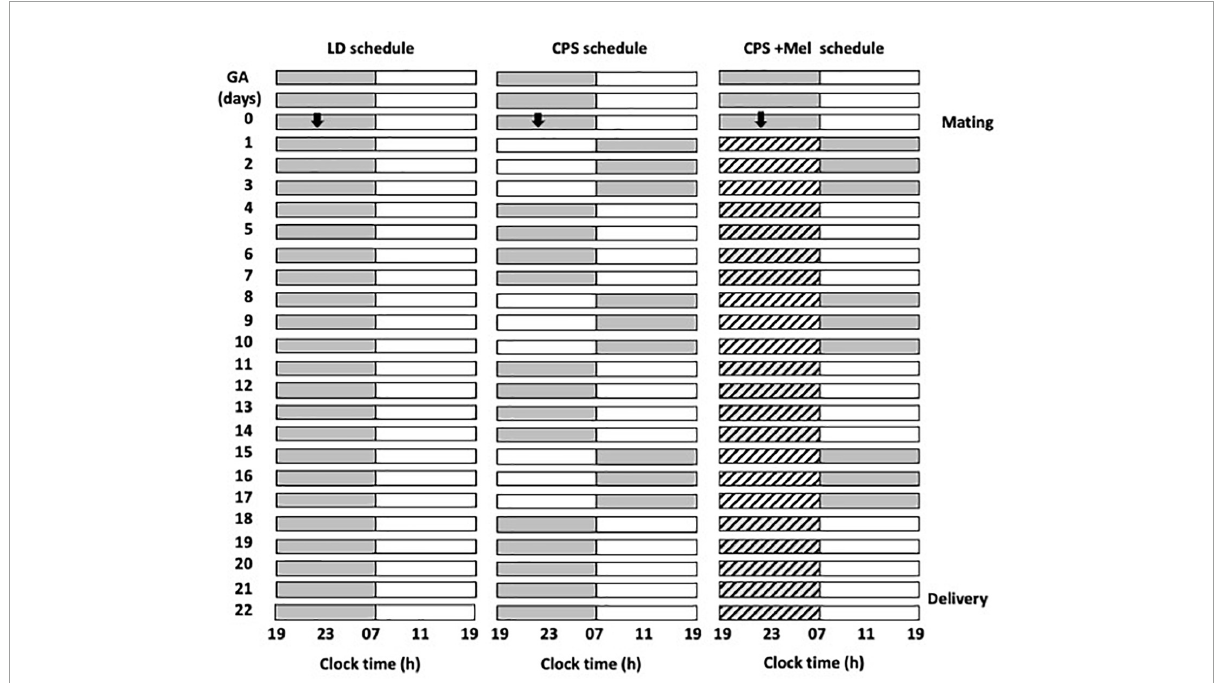
FIGURE1 Schematic representation of the photoperiod protocols used throughout gestation. Three cohorts of female rats raised and maintained in photoperiod 12-h light and 12-h dark were mated and separated into three groups: LD photoperiod, CPS photoperiod, and CPS+Mel, corresponding to females under CPS that received melatonin in drinking water during subjective night (19:00–07:00). In CPS, the photoperiod was shifted by 12 h for three consecutive cycles, after which the dark phase was extended for 12 h to restore the original photoperiod for a further 4 days. The melatonin treatment was available from GA 1 until delivery (GA, gestational age).